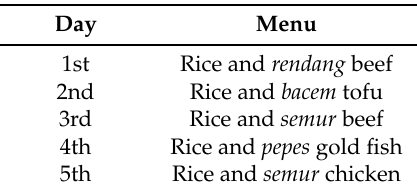
Table 1. Cyclus of 5 day menu for 30 days duration of intervention studies on ethnic ready to eat foods for respondents in Cikadu camp. The type of menus were repeated and administered to the targeted respondents on 5 day